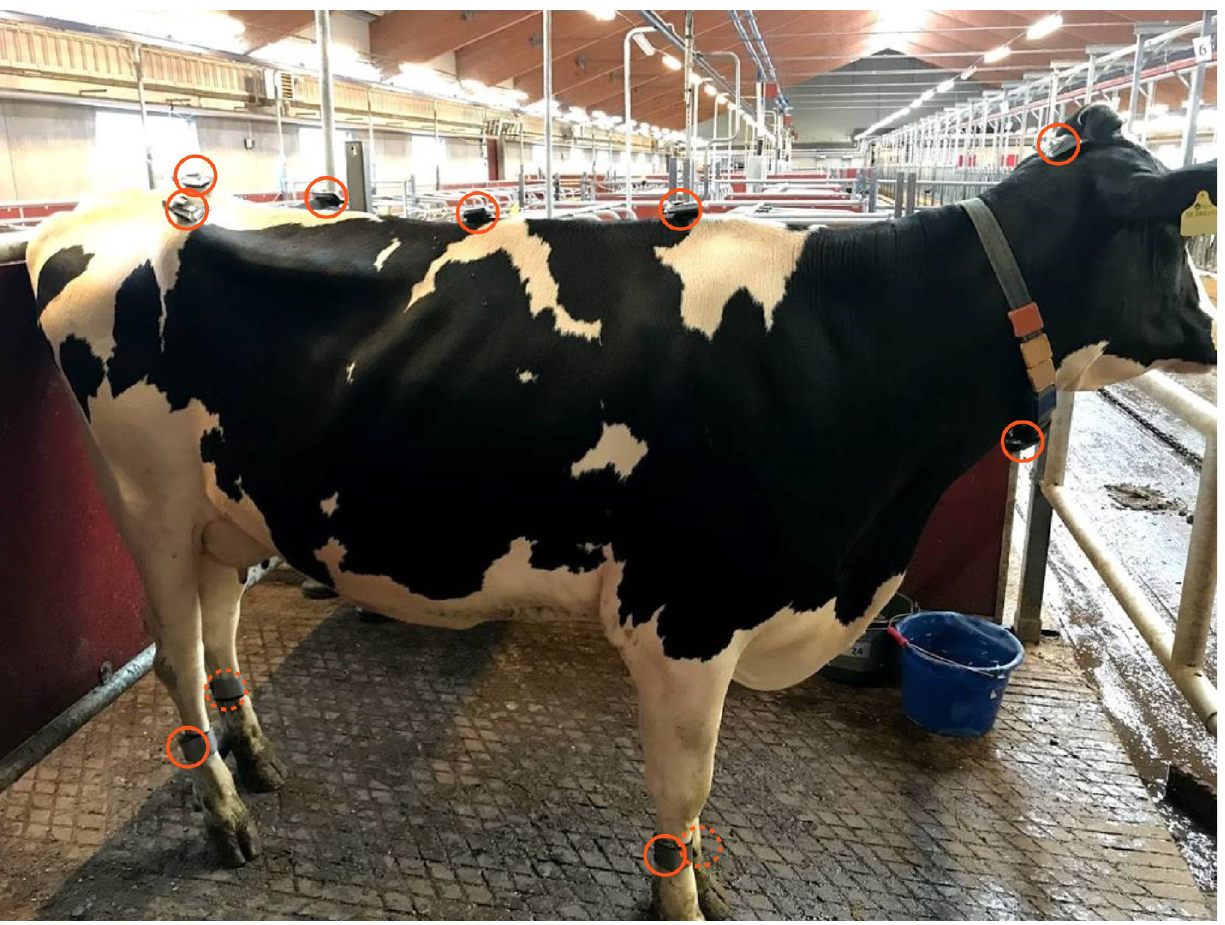
Fig 1. Cow equipped with IMU sensors on predefined anatomical landmarks. IMUs are indicated with orange circles; just caudal to the nuchal crest, the highest point of the withers, the spinal process of the 13 th thoracic vertebra, between the tubera sacrale of the pelvis, right and left tuber coxae, lateral aspect of the metatarsus/metacarpus of each limb and one sensor was attached on the inner right side of neck collar.